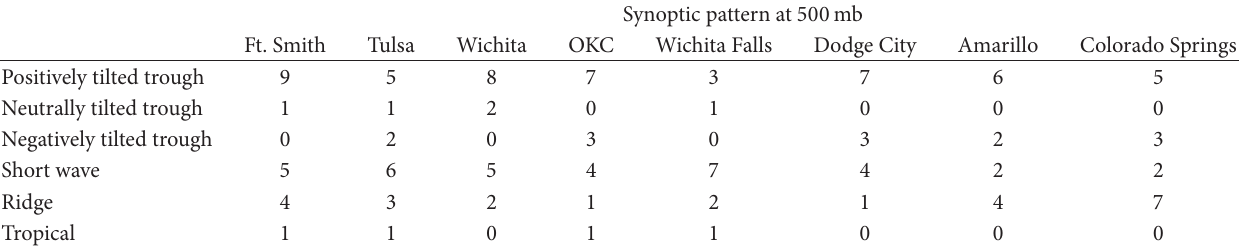
Table 3: The synoptic pattern at 500 mb leading up to the rainfall event at each location.